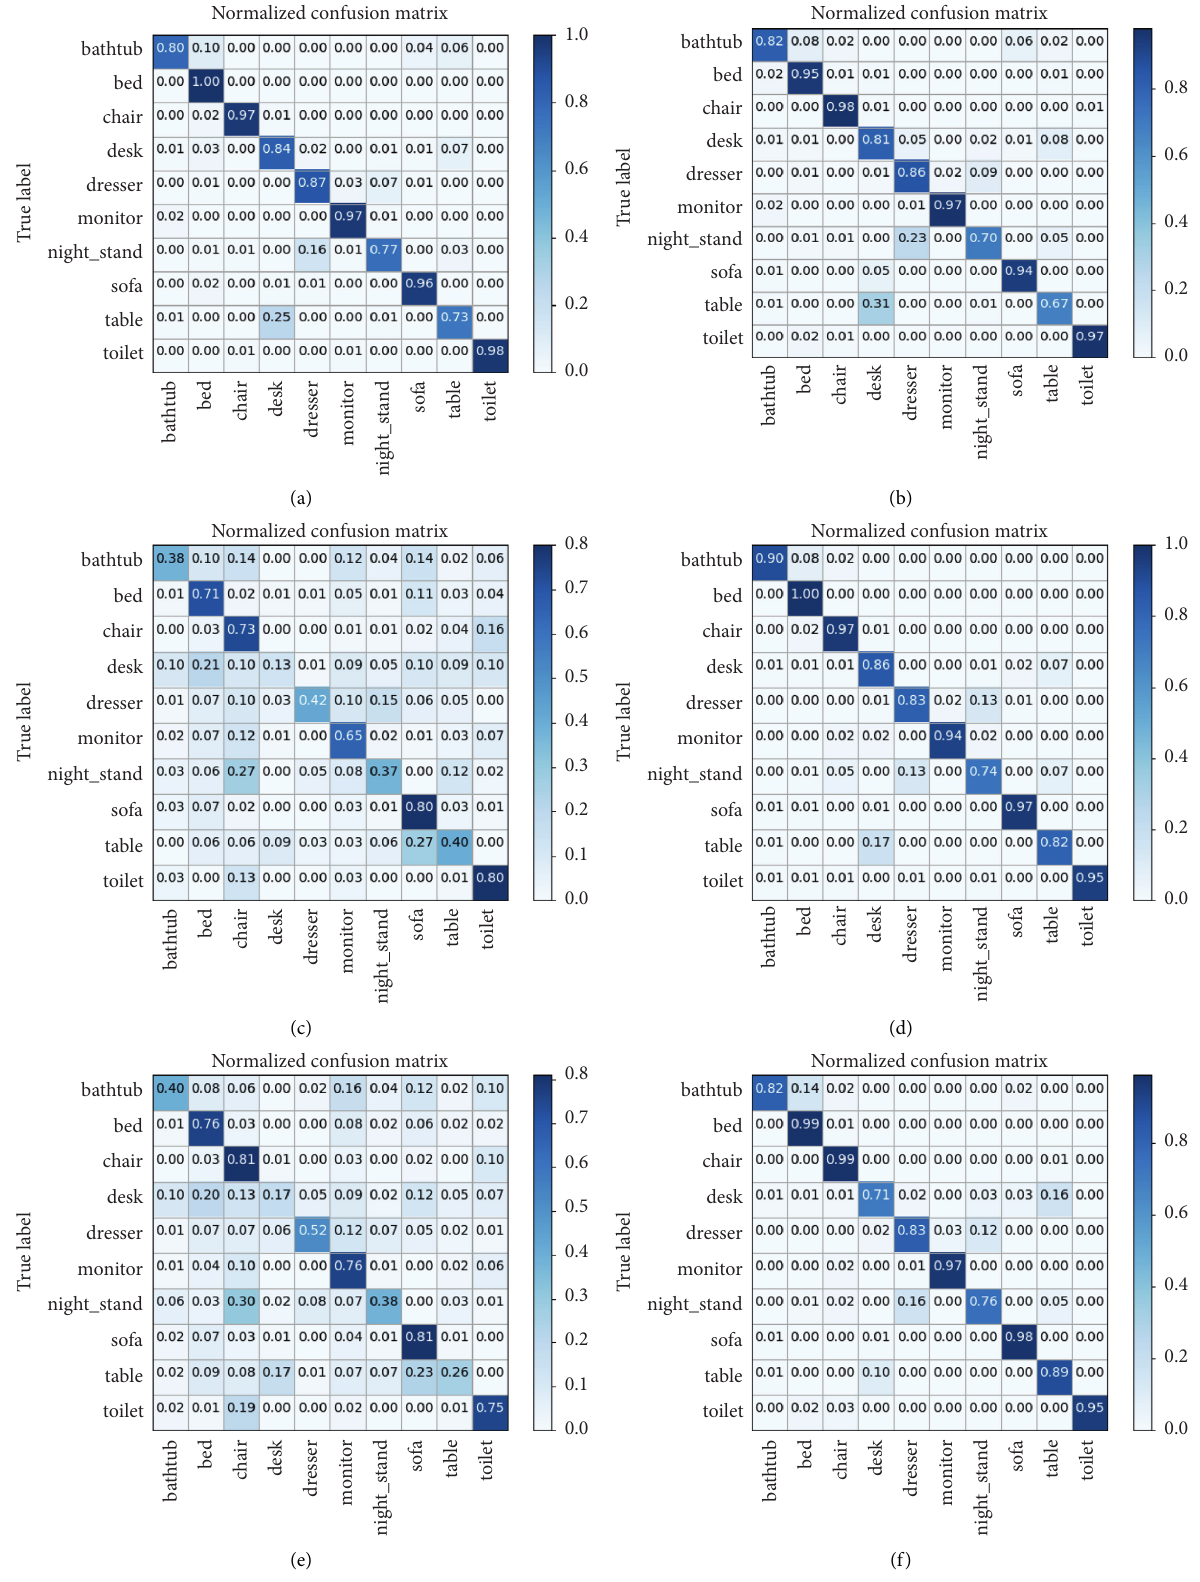
Normalized confusion matrix